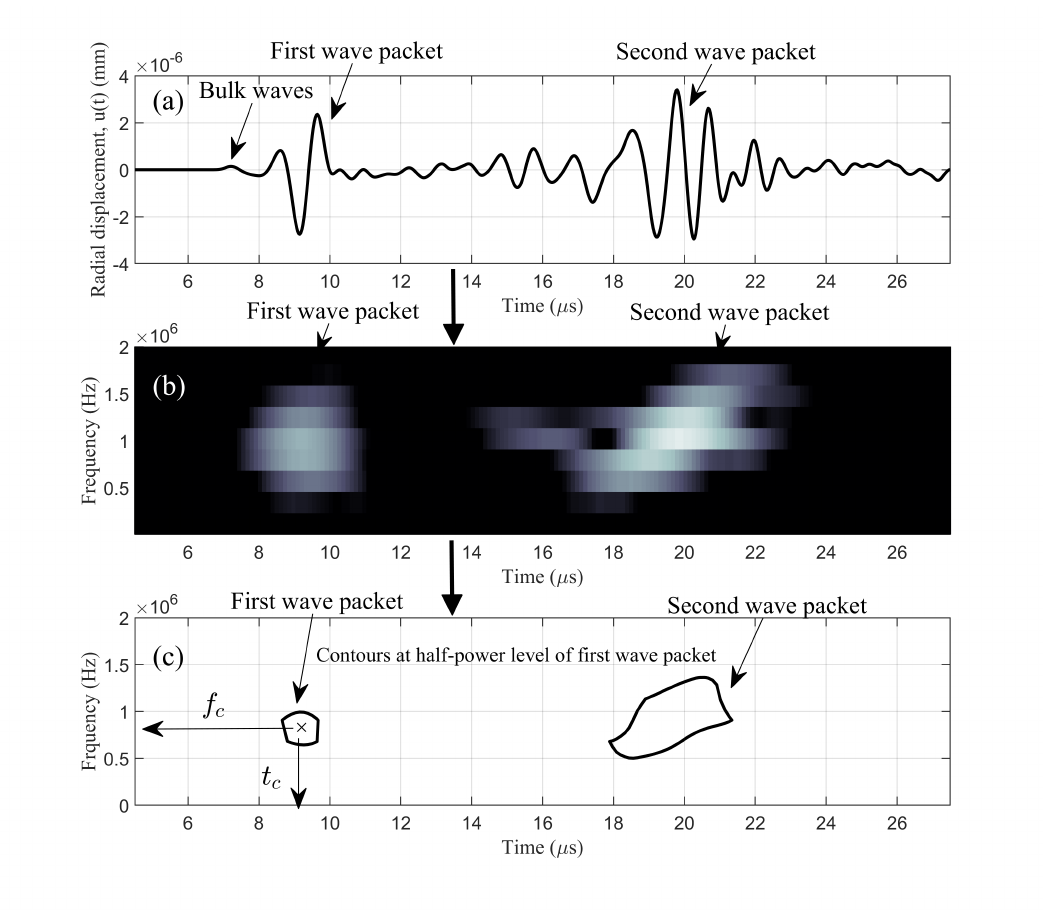
Figure 4. ( a ) Time domain radial displacement u ( t ) collected at receiver R; ( b ) spectrogram U ( t , f ) obtained by applying short-time Fourier transform (STFT) to u ( t ) ; ( c ) contours at half-power level of the first wave packet ( f c is the centroid of the contour for the first wave